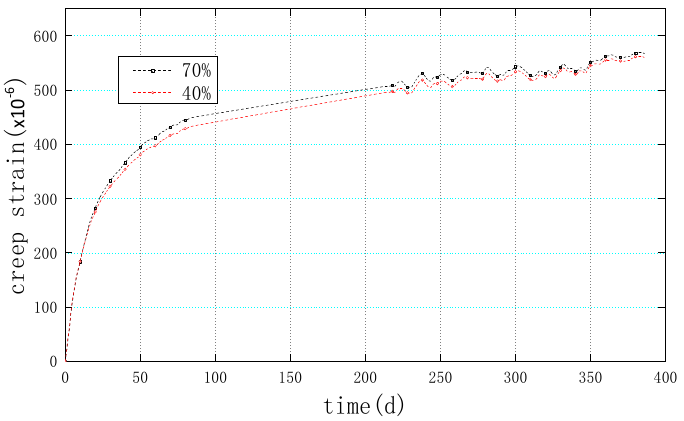
Figure 10. Evolution of reinforcement strain in the compression zone of the RC T ‐ beam for two loading levels (loading age of 3 days).